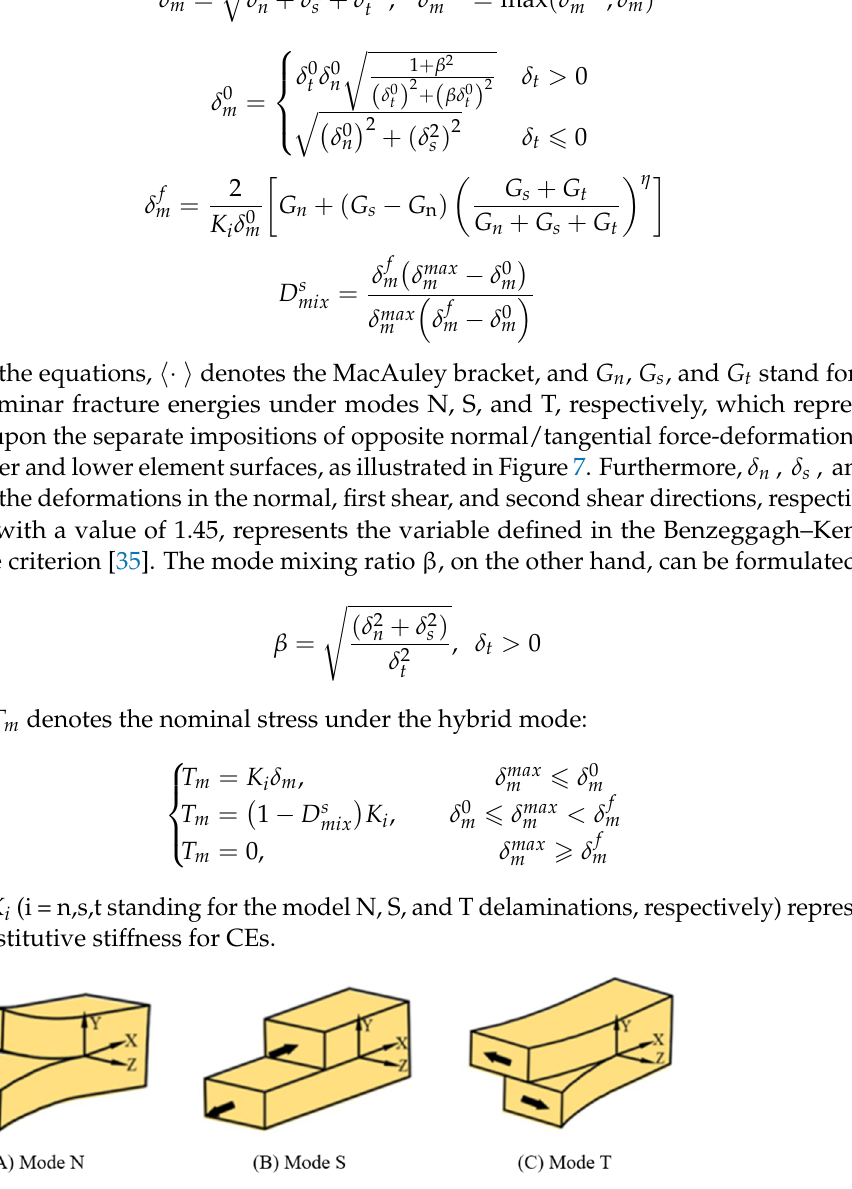
Figure 7. Delamination modes of cohesive model: ( A ) mode N; ( B ) mode S; ( C ) mode T. Table 4 details the interface layer-related constants. The stiffness for resin-rich inter- pile interface was expressed as = / by Daudeville et al. [36], where (=10.5